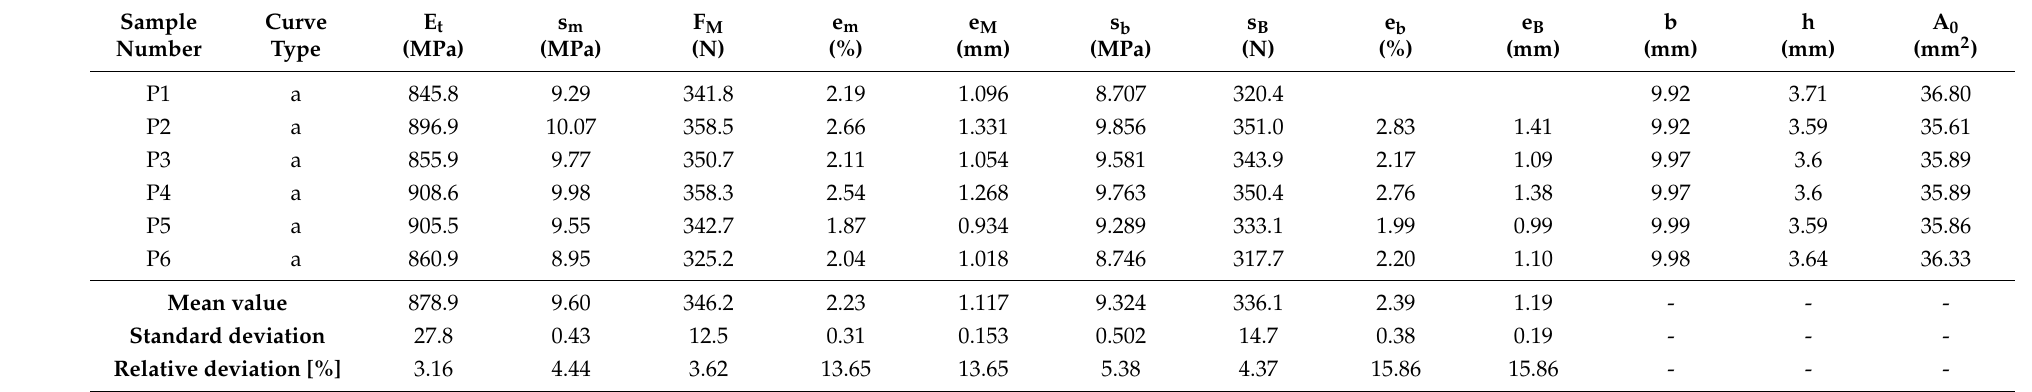
Table A39. Results of the tensile tests of